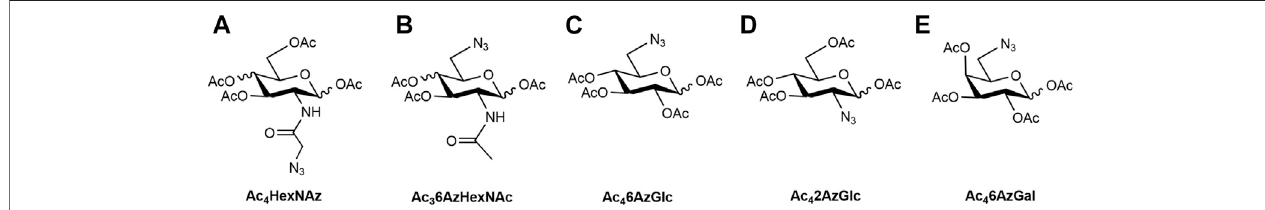
4 6AzGalfor72 husingaCCK-8cell-proliferationassay.